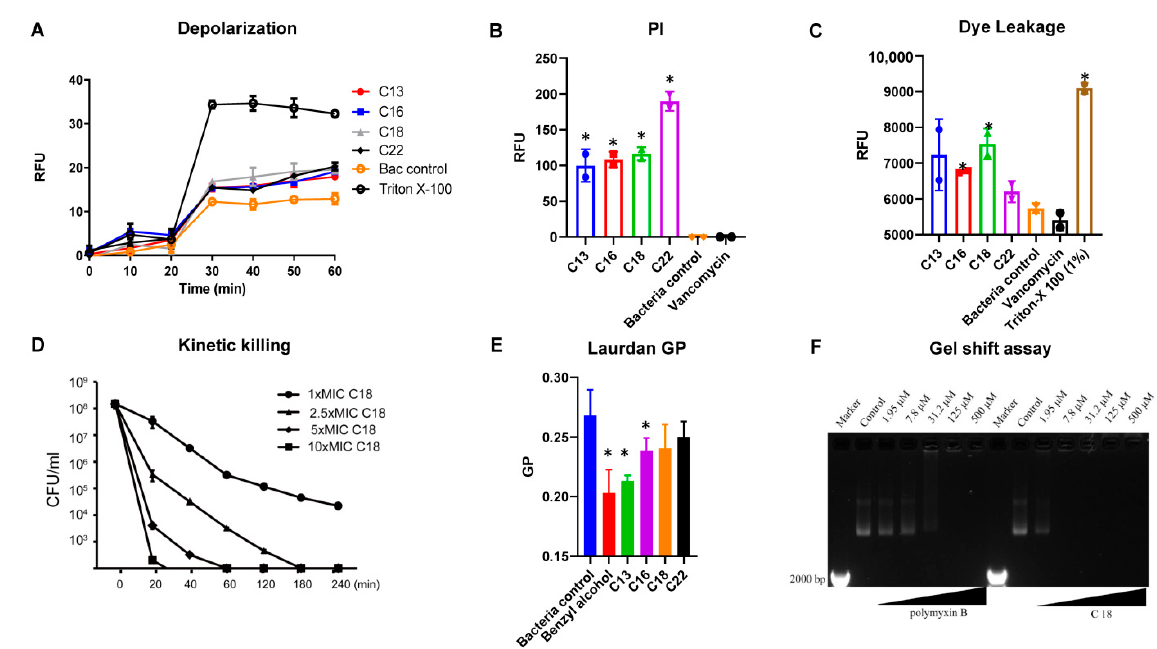
Figure 2. The interaction of Cec4-derived peptides with the cell membrane and DNA of S. aureus MW2 ( A ) Membrane depolarization of the bacterial surface upon treatment of peptides C13, C16, C18 and C22 at 32 µg/mL, accessed by the DISC3 (5) dye. Triton X-100 (1%) was used as a control. ( B ) Membrane permeation of propidium iodide as a pore formation mechanism marker. The percentage of permeabilization is plotted to compare with 1% Triton X-100 at a peptide concentration of 32 µg/mL. ( C ) Dye leakage of rhodamine-BF from DOPC: cholesterol liposomes. ( D ) Kinetic killing of S aureus persisters ( E ) Laurdan GP plots measuring membrane fluidity change upon the interactions between the peptides and ( F ) The plasmid shift caused by the peptide DNA binding. * p < 0.05, Student’s t-test was compared with the control.